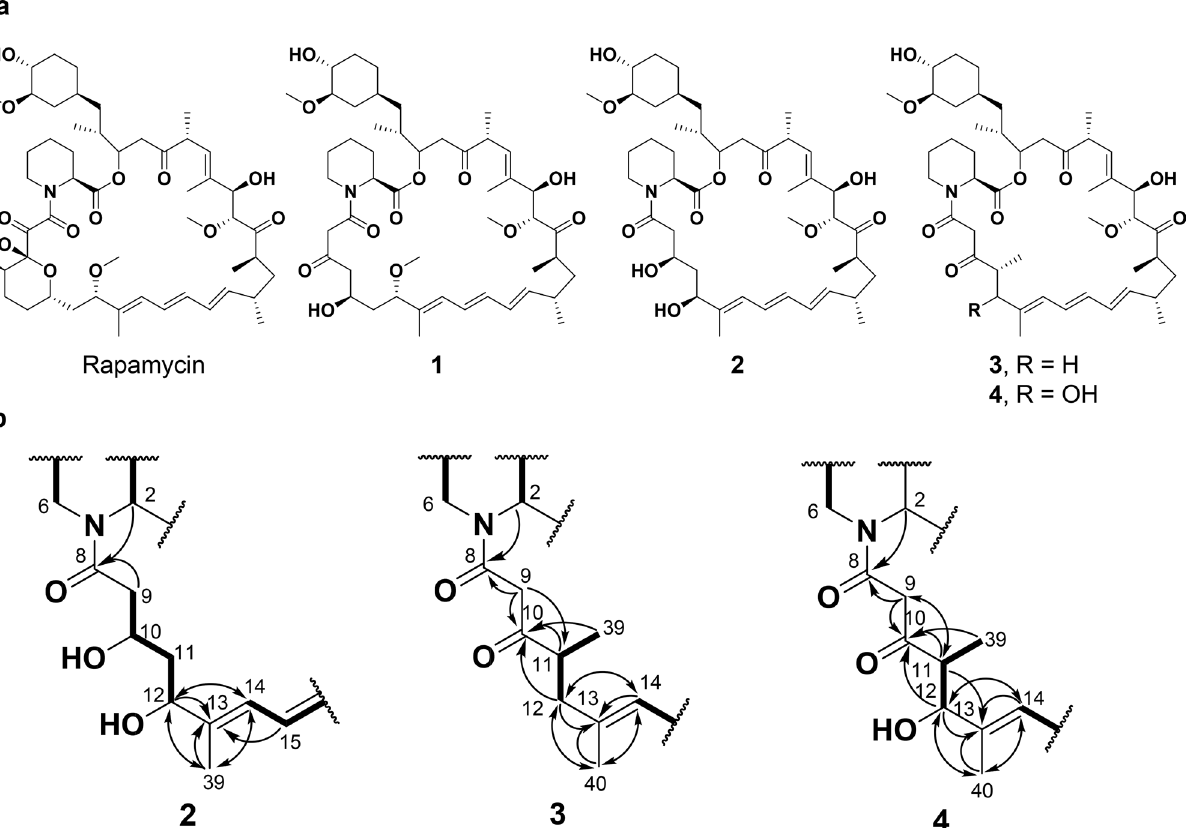
Figure 3. Structural determination of newly isolated hemiacetal-less rapamycin derivatives. ( a ) Structures of rapamycin and compounds 2 – 4 . The stereochemistry of the derivatives is deduced from that of rapamycin as well as the stereoselectivities of corresponding tailoring domains. ( b ) Selected 1 H– 1 H DQF-COSY and HMBC correlations in 2 – 4 . Bold lines and arrows show DQF-COSY and HMBC correlations,